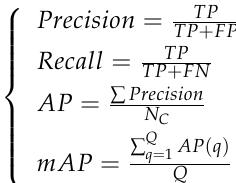
Figure 11. The loss curve and PR curve after model convergence. The stem point cloud extracted based on the stem detection results is shown in Figure 12. Figure 12b shows the mask processing results based on the stem bounding box. Figure 12c shows the ROI of the extracted stem coordinates. Figure 12d shows the stem point cloud obtained from the depth image based on the RGB-D camera parameters. Noting that the stem area coordinates in the color image are completely the same as those in the depth image for RGB-D camera frames, the stem depth values in the depth image can be extracted according to the stem pixel location in the color image.